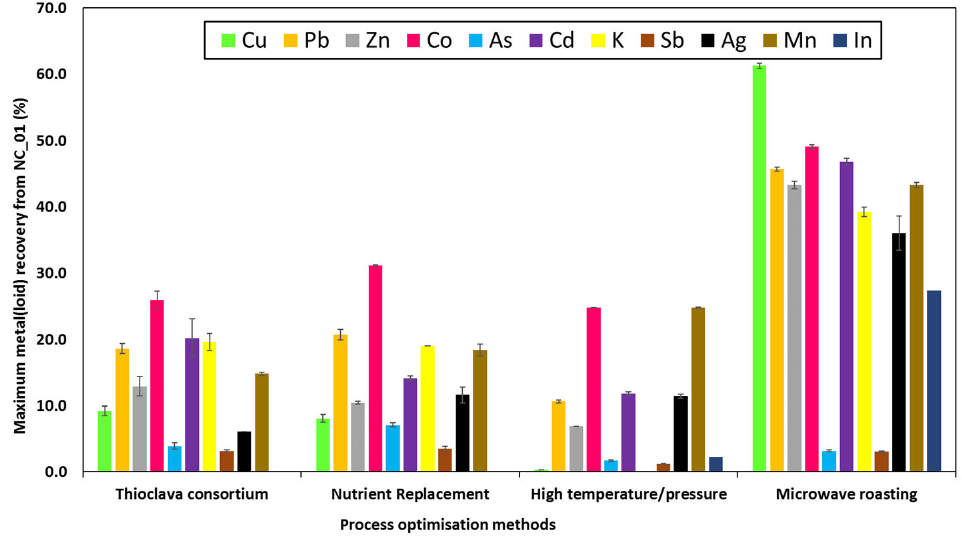
Figure 4. Maximum percentage of metal(loid)s extracted from the Neves Corvo waste rock (NC_01) by the Thioclava spp. via four process optimisation methods. Values are the average of duplicate flasks ± standard deviations.